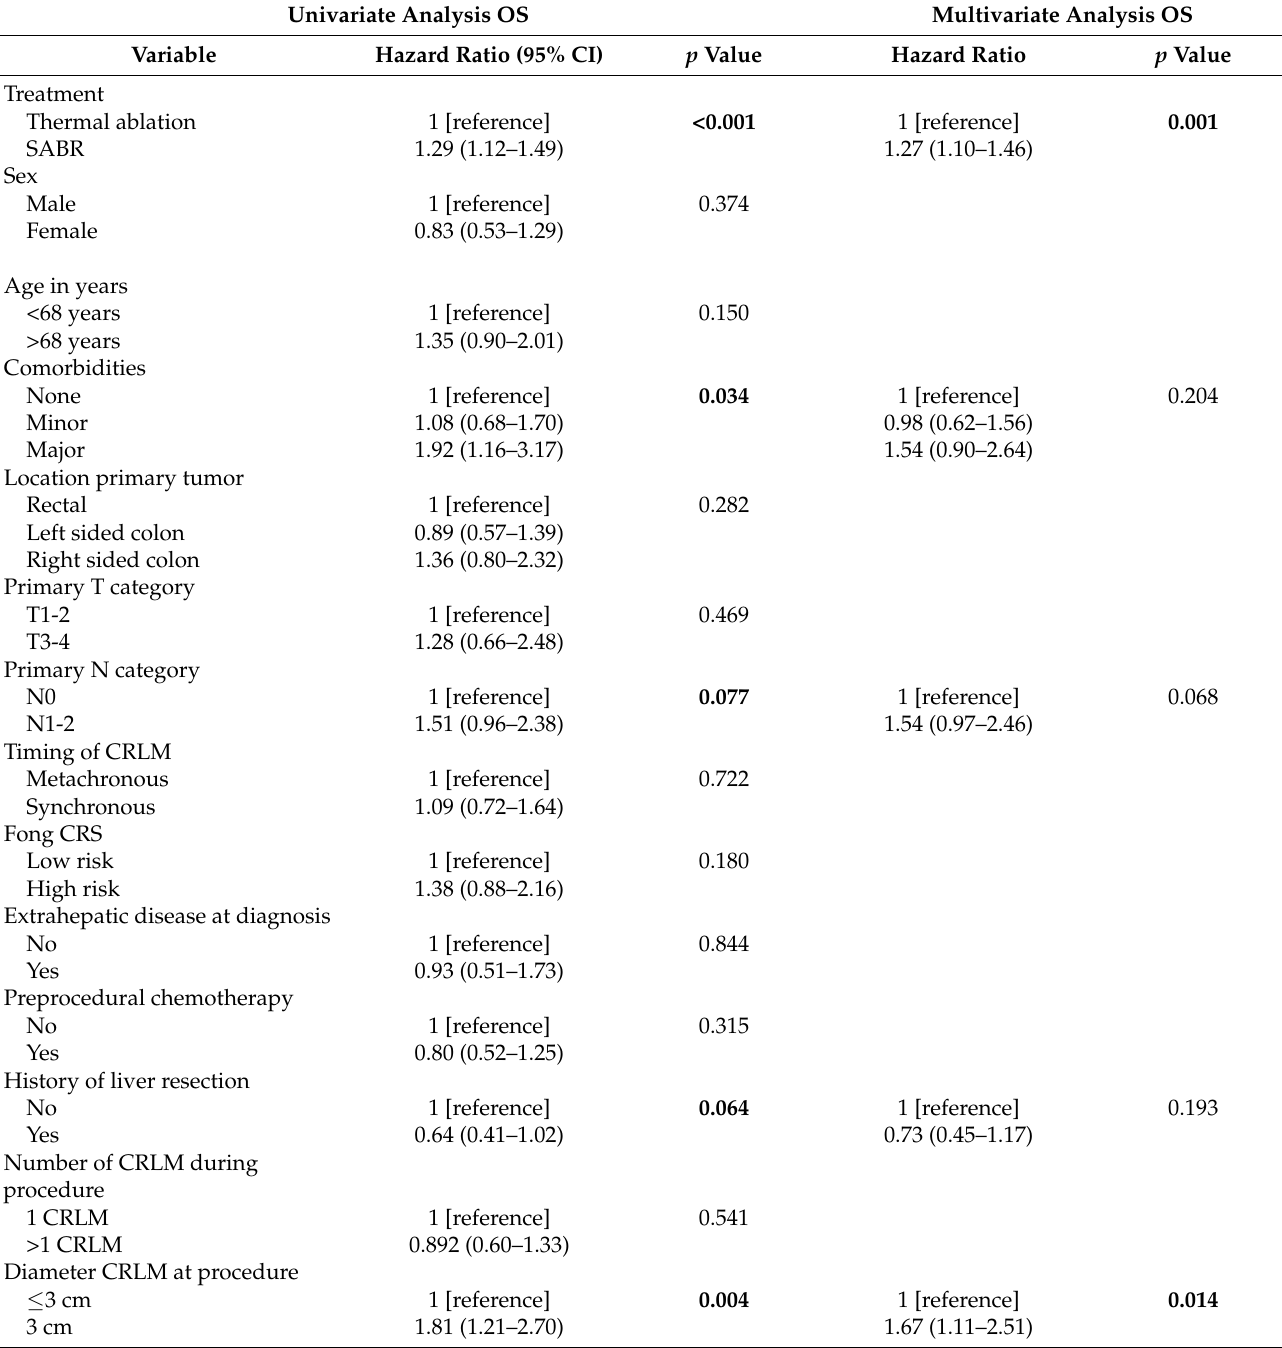
Table 2. Variables associated with OS in univariate Cox regression analysis and potential confounders in multivariate Cox regression analysis for OS when comparing SABR to thermal ablation (bold type significant